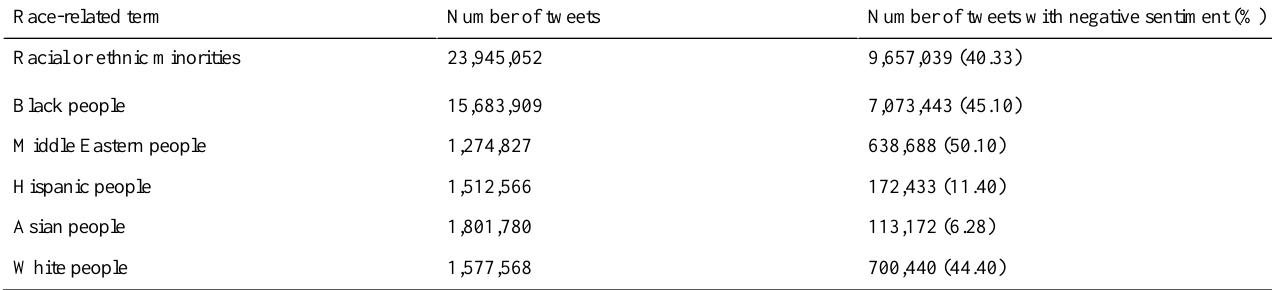
Table 2. Negative sentiment for race-related terms used in tweets.